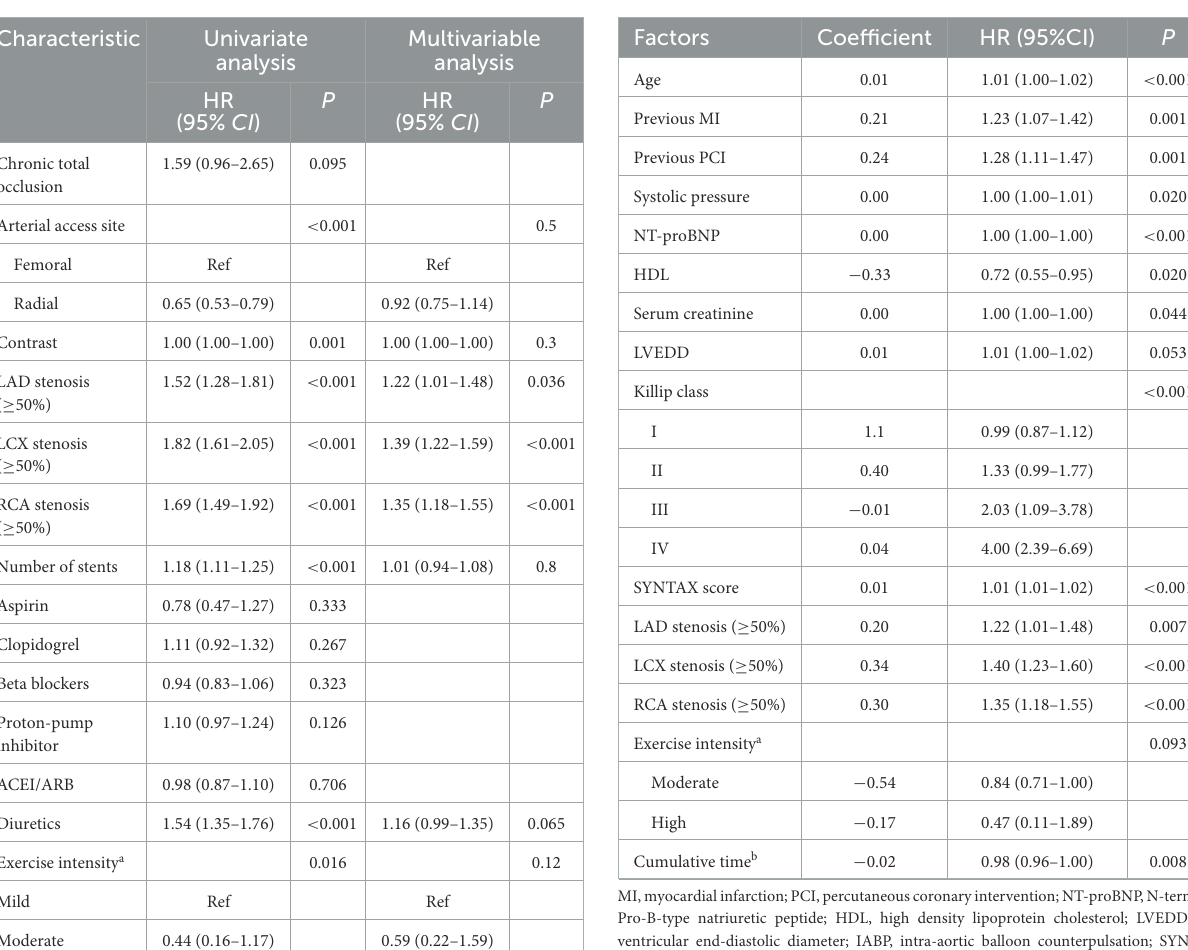
TABLE 3 Selected variables for model